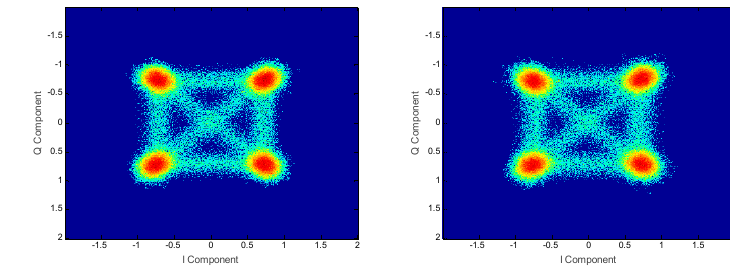
Figure 10. QZS-2 satellite L5 frequency signal constellation diagram.